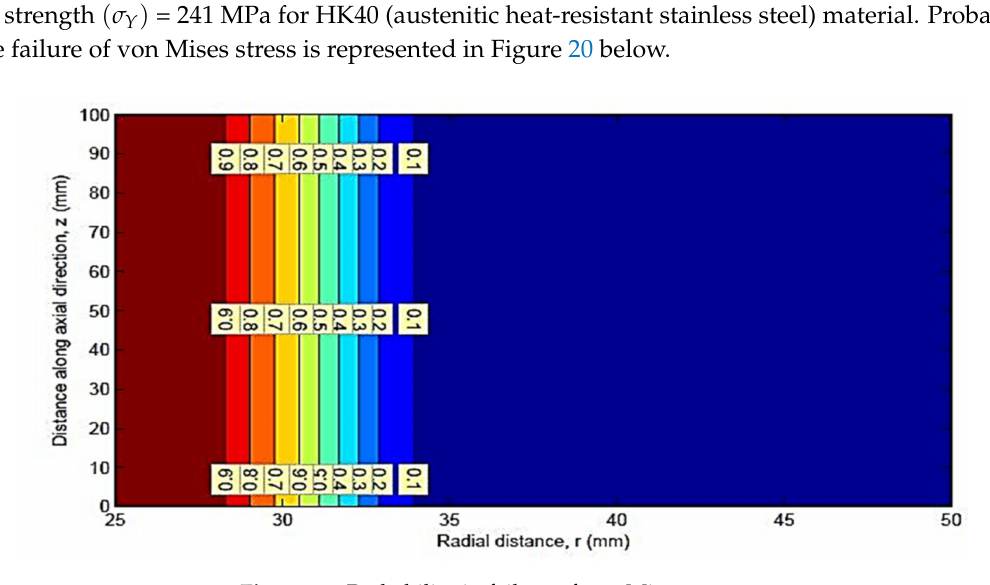
Figure 20. Probability in failure of von Mises